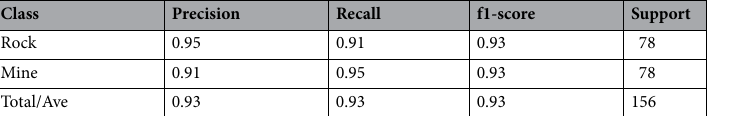
Table 1. The classifier’s performance is obtained based on the training data corresponding to the imbalanced dataset.